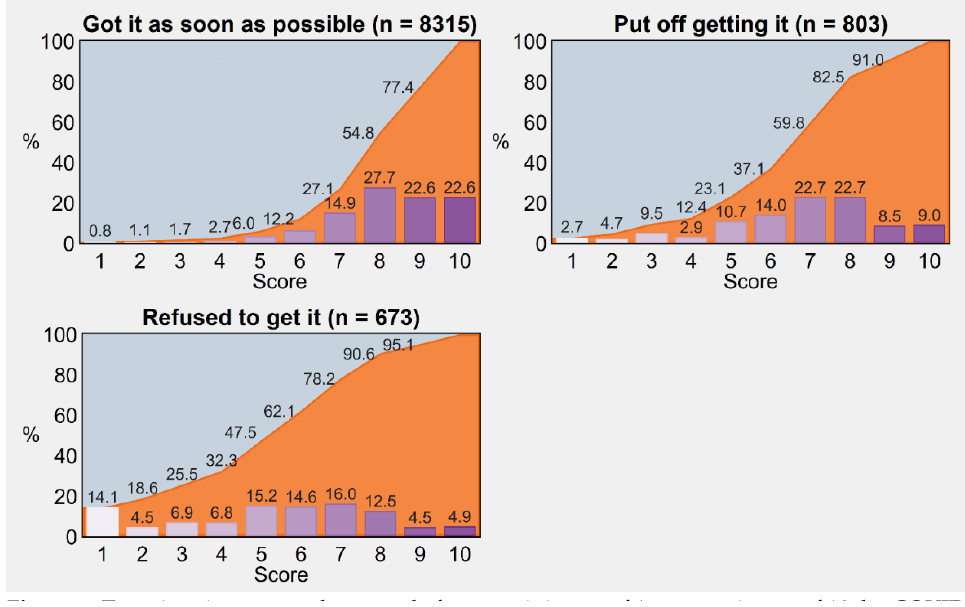
Figure 2. Trust in science scored on a scale from a minimum of 1 to a maximum of 10, by COVID-19 vaccine uptake status. Percentages were post-stratified by using the distribution of Italy’s resident adult population by NUTS region, gender, and age group as of 1 January 2022. Notes: Cumulative frequencies are displayed with the aid of area charts in the background. Trust among vaccine-exempt individuals is not displayed due to small numbers ( n = 209). Abbreviations: COVID-19, coronavirus disease 2019; NUTS, Nomenclature of Territorial Units for Statistics.